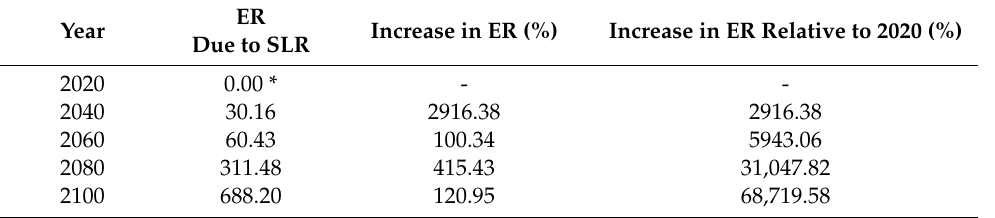
Table 3. Economic Risks (ER) at Fethiye due to Sea Level Rise (SLR).